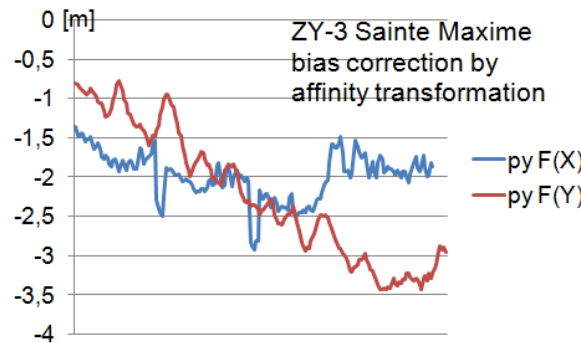
Figure 5. Systematic y-parallaxes of Ziyuan-3 (3.4m GSD) for bias correction by affinity transformation